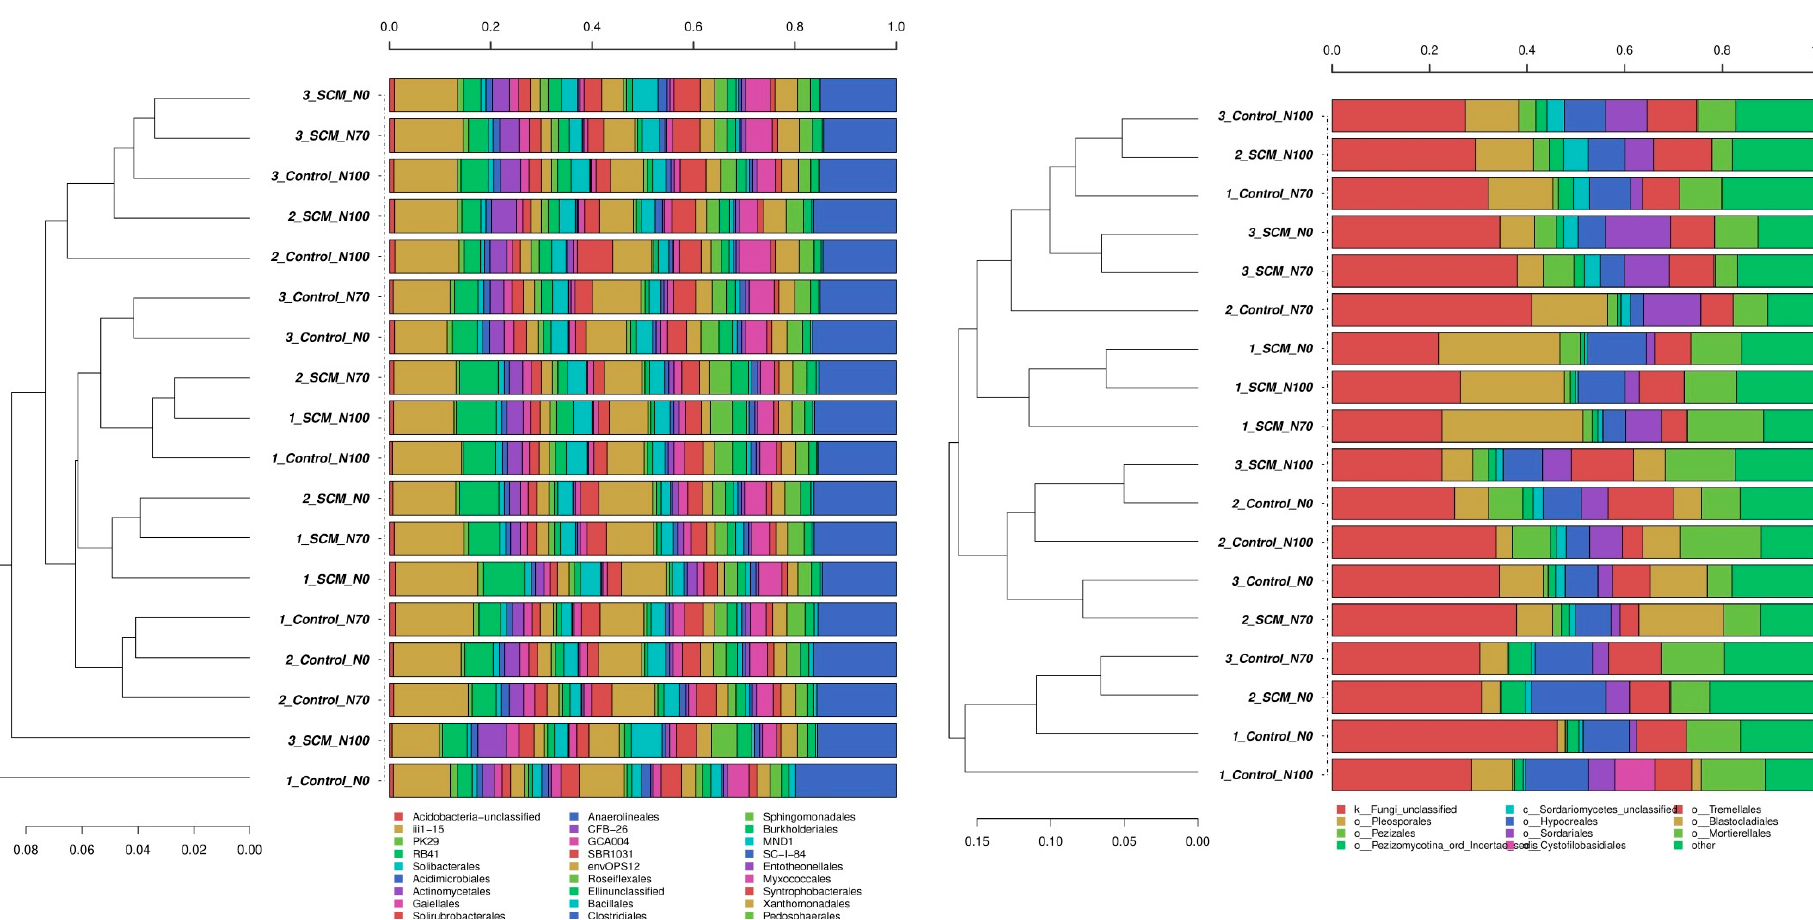
Figure 3. Taxonomic comparison of all samples (a, bacteria; b, fungi) through hierarchical clustering of microbial communities at the order level across all samples used in this study. Clusters were identified with the average linkage algorithm for taxa that contributed at least 5% to a single sample. Taxa that contributed less than this threshold were added to the sequence group denoted “other”. Control_N0 = Control with 0% N-fertilization; Control_N70 = Control with 70% N-fertilization; Control_N100 = Control with 100% N-fertilization; SCM_N0 = SCM with 0% N-fertilization; SCM_N70 = SCM with 70% N-fertilization; SCM_ N100 = SCM with 100% N-fertilization.